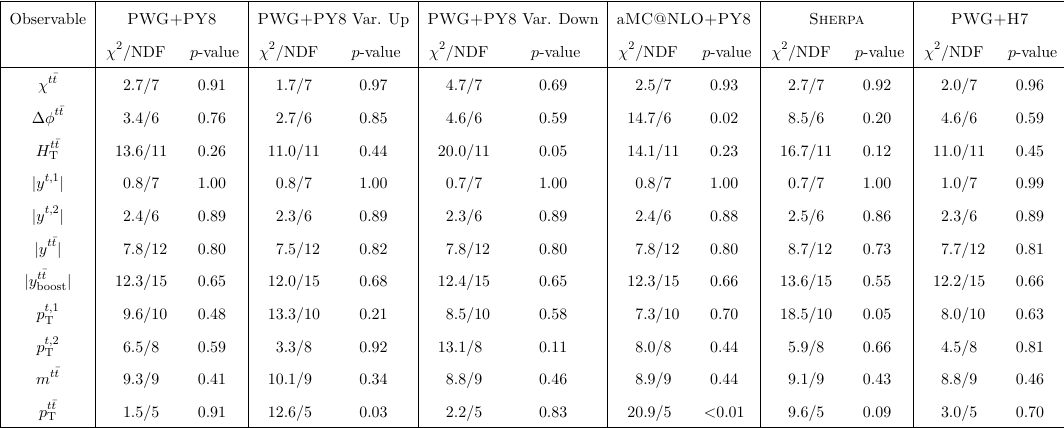
Table 12 . Comparison of the measured parton-level absolute single-differential cross-sections with the predictions from several MC generators. For each prediction, a χ 2 and a p -value are calculated using the covariance matrix of the measured spectrum. The number of degrees of freedom (NDF) is equal to the number of bins in the distribution.